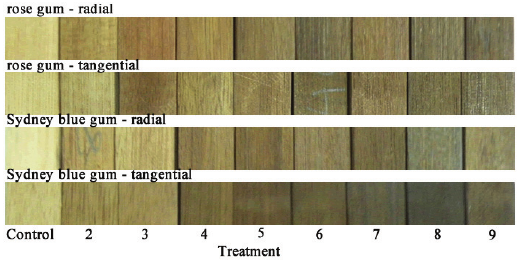
Table 2. Summary of factorial analysis of variance with additional treatment for the parameters L* , a* and b* in radial and tangential direction of rose gum and Sydney blue gum woods.